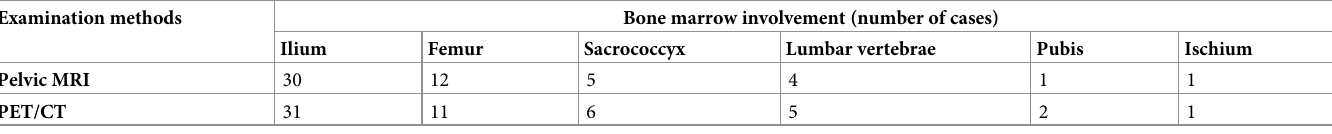
Table 6. BMinv detected using both pelvic MRI and PET/CT in 39 DLBCL patients. Examination methods